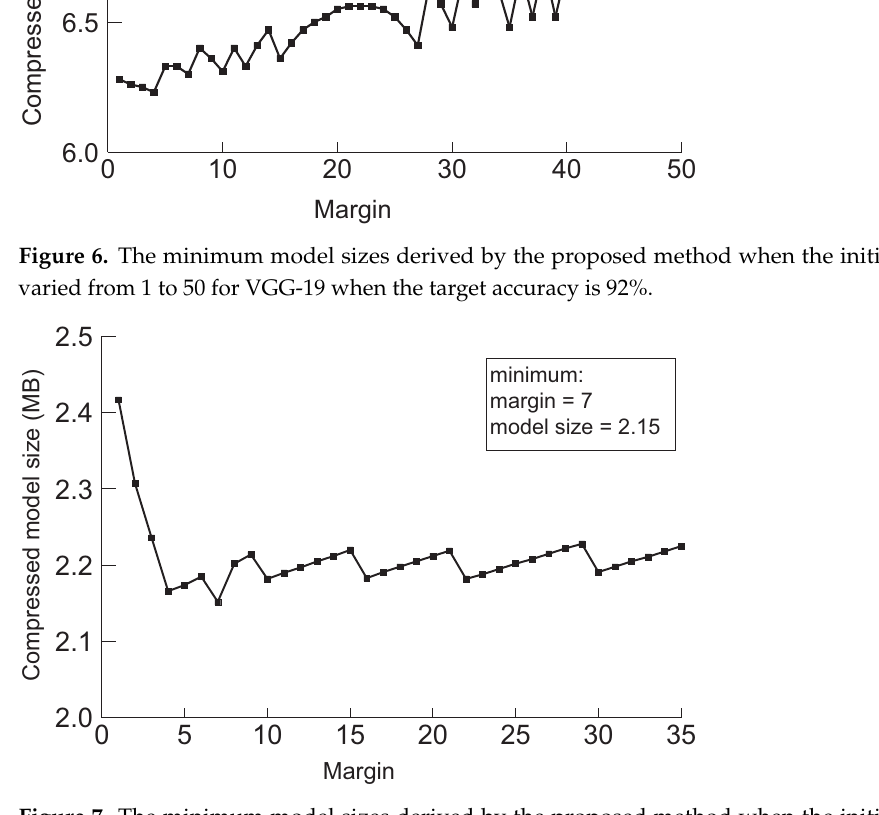
Figure 7. The minimum model sizes derived by the proposed method when the initial margin is varied from 1 to 50 for ResNet-110 when the target accuracy is 94%.